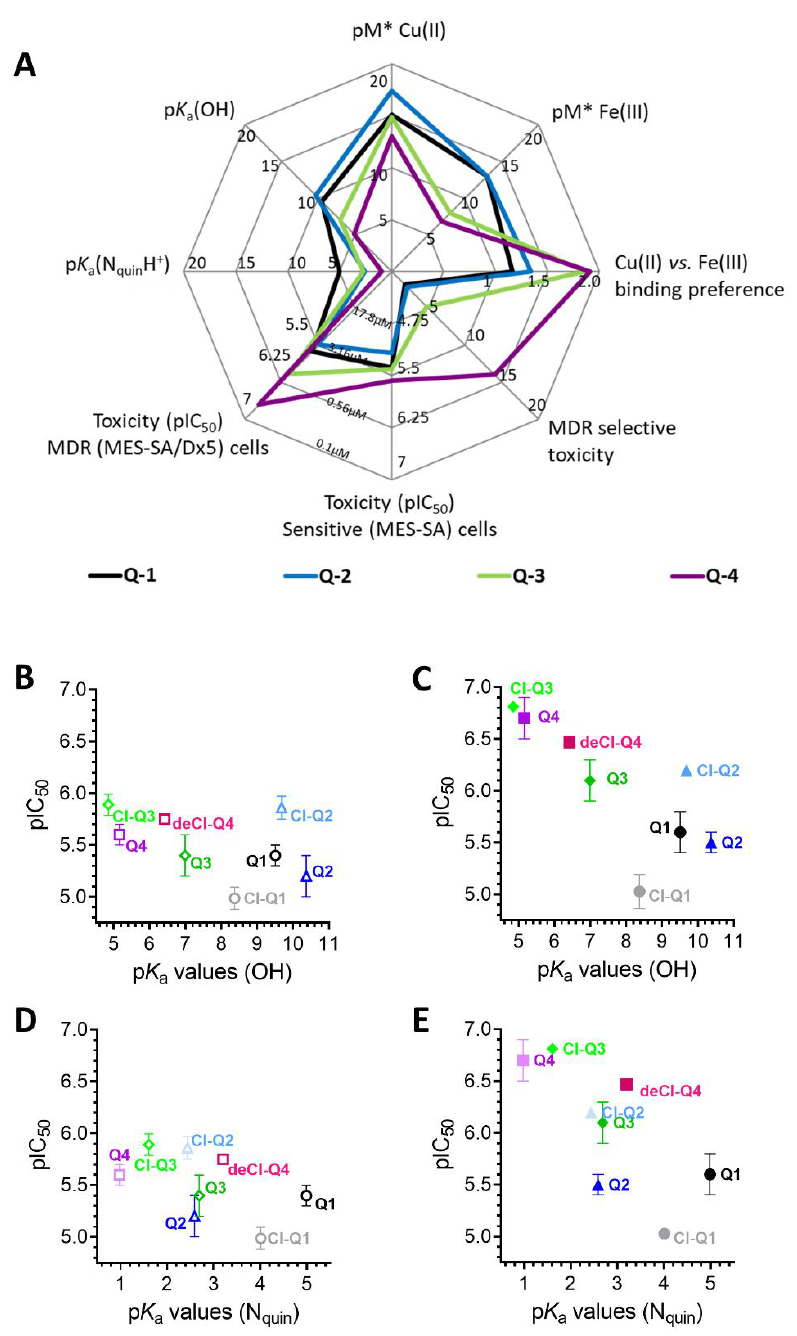
Figure 1. Impact of ligand deprotonation and metal binding properties on MDR-selective anticancer activity. ( A ) Spider diagram showing the relations of solution chemical properties [60] and MDR selective anticancer activity of the four investigated derivatives Q-1 (black), Q-2 (blue), Q-3 (green) and Q-4 (purple). p K a values as well as metal binding capacities of the ligands (expressed as pM* = − log(unbound metal ion)) influence MDR-selective toxicity of 8-hydroxyquinoline derivatives. Detailed correlation plots for the single properties are shown in Figure S15. The impact of p K a values of the hydroxyl group ( B , C ) and the quinolinium nitrogen ( D , E ) on toxicity against MES-SA ( B , D ) and MES-SA/Dx5 ( C , E ) cells is shown for Q-1 to Q-4 as well as for the chlorinated derivatives Cl-Q-1 (grey), Cl-Q-2 (light blue), Cl-Q-3 (bright green), and the De-Cl-Q-4 (magenta). Toxicity is displayed as pIC 50 values, the negative decadic logarithm of the half maximal growth-inhibitory concentration.